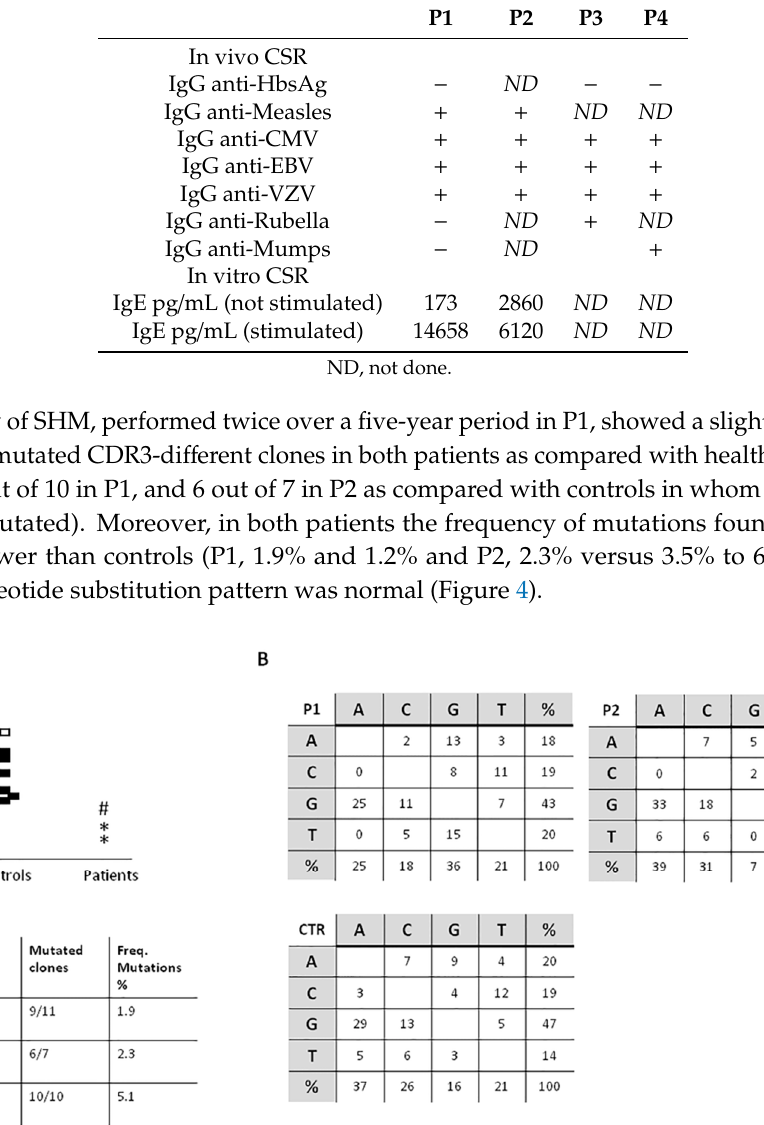
Table 3. In vivo and in vitro class switch recombination (CSR).